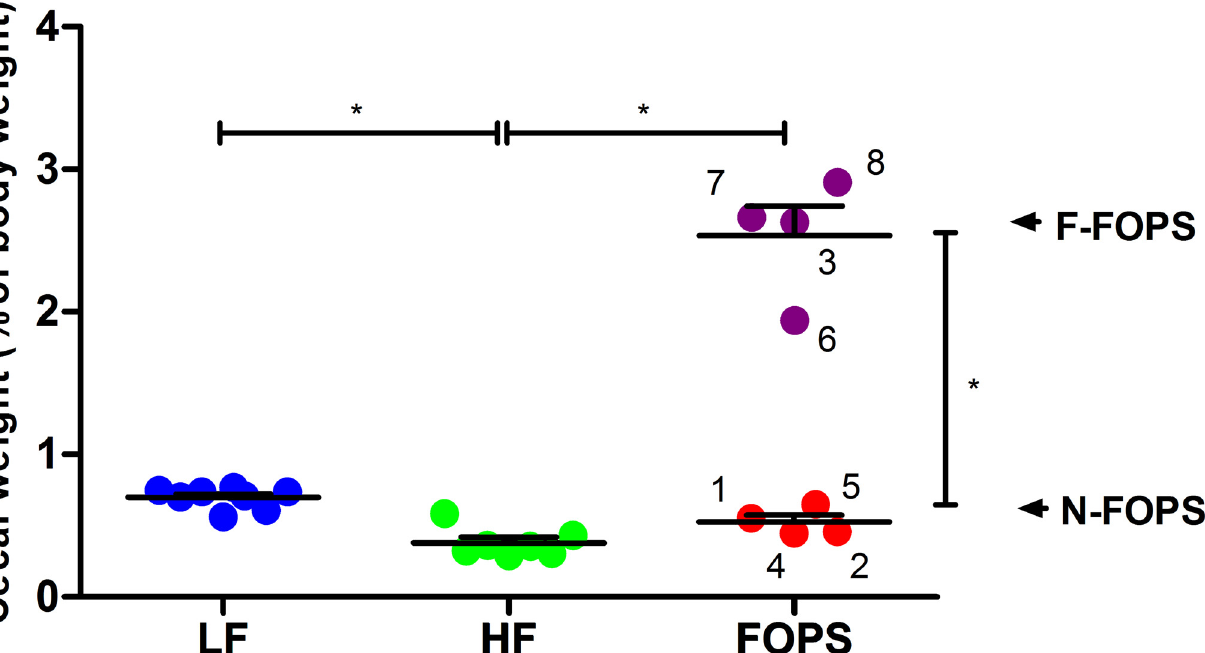
Fig 1. Inter-individual variation in full cecal weights of mice fed a HF diet supplemented with FOPS. Data are presented as mean ± SEM; n = 8 mice/ group for LF, HF, and FOPS; n = 4 mice/group for N-FOPS and F-FOPS; mouse numbers are shown for FOPS mice to track individual mice across figures; * indicates a significant difference (p < 0.05) between the indicated treatments using Bonferroni ’ s multiple comparison test with the following comparisons: LF vs. HF; HF vs. N-FOPS; HF vs. F-FOPS; N-FOPS vs.